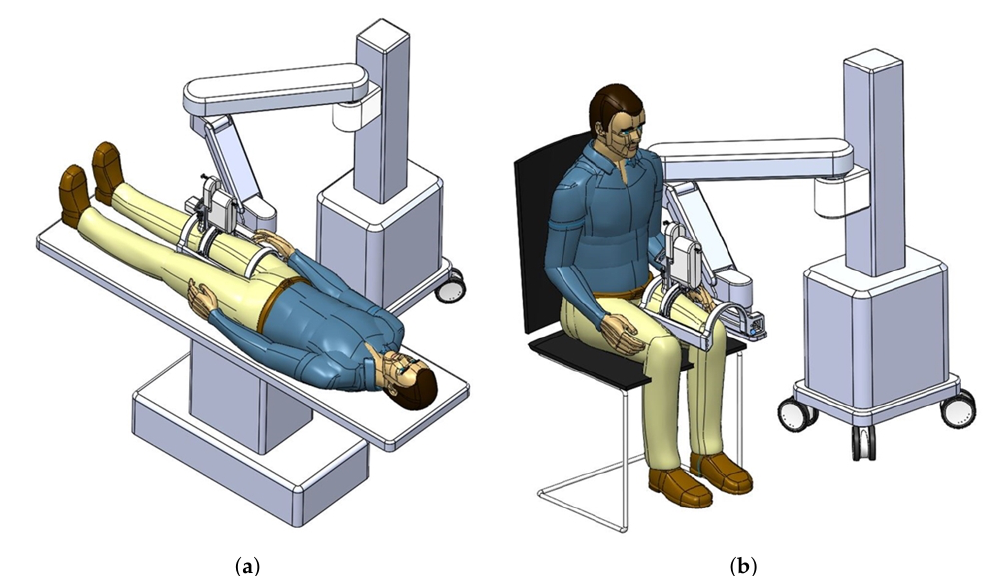
Figure 2. Usages of the developed sarcopenia detection system. ( a ) Lay down usage. ( b ) Sit down